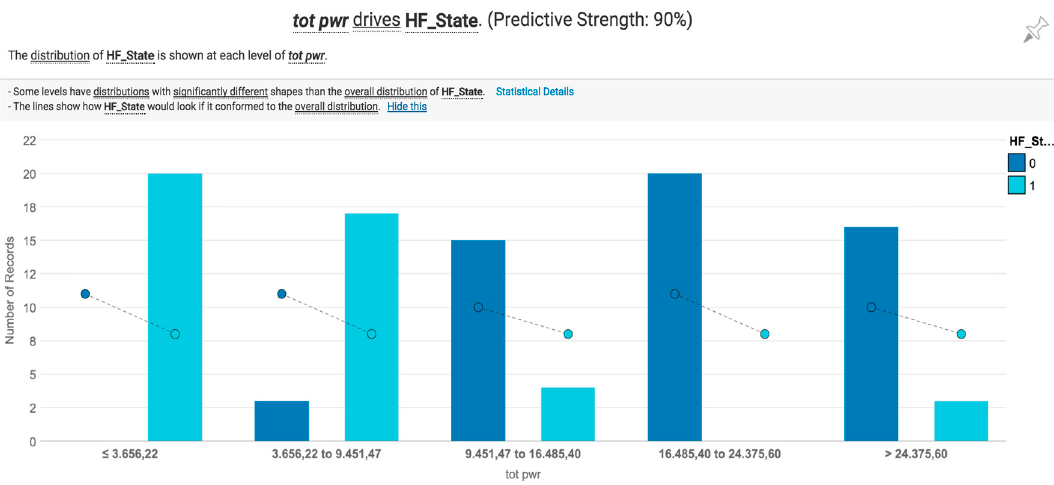
Figure 11. Results for Long Term Hearth Rate Variability (HRV), using TOT_PWR as single predictor.